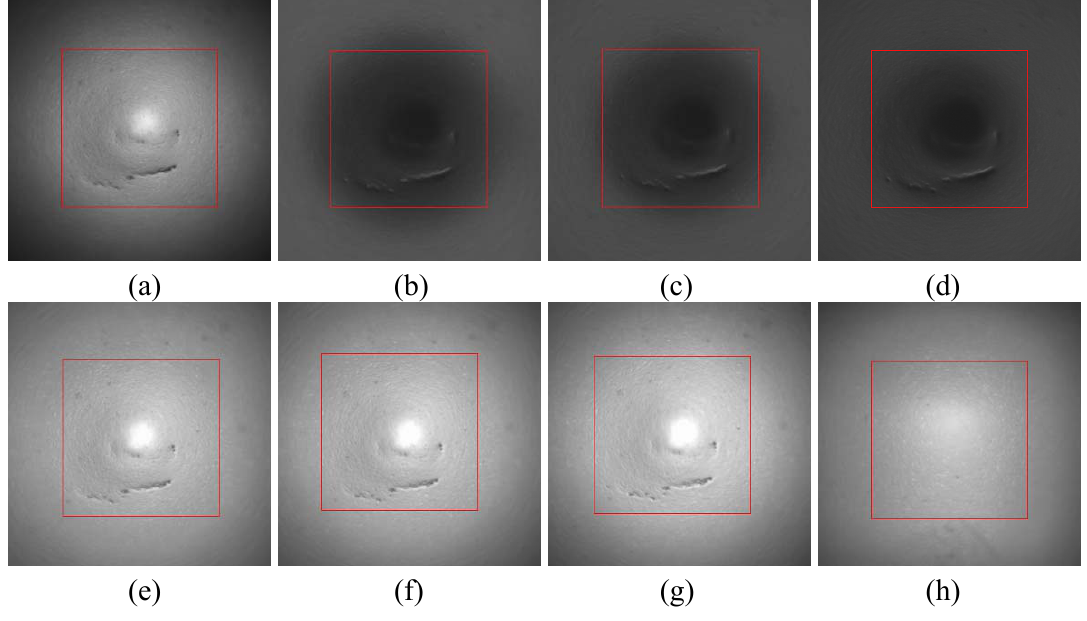
1. Target region gray scale uniformity analysis: Illuminance uniformity is estimated by gray scale uniformity U of the target region, where a lower value indicates better uniformity. As shown in Equation (7), variance and mean gray scale are denoted by Var and Ave , respectively.